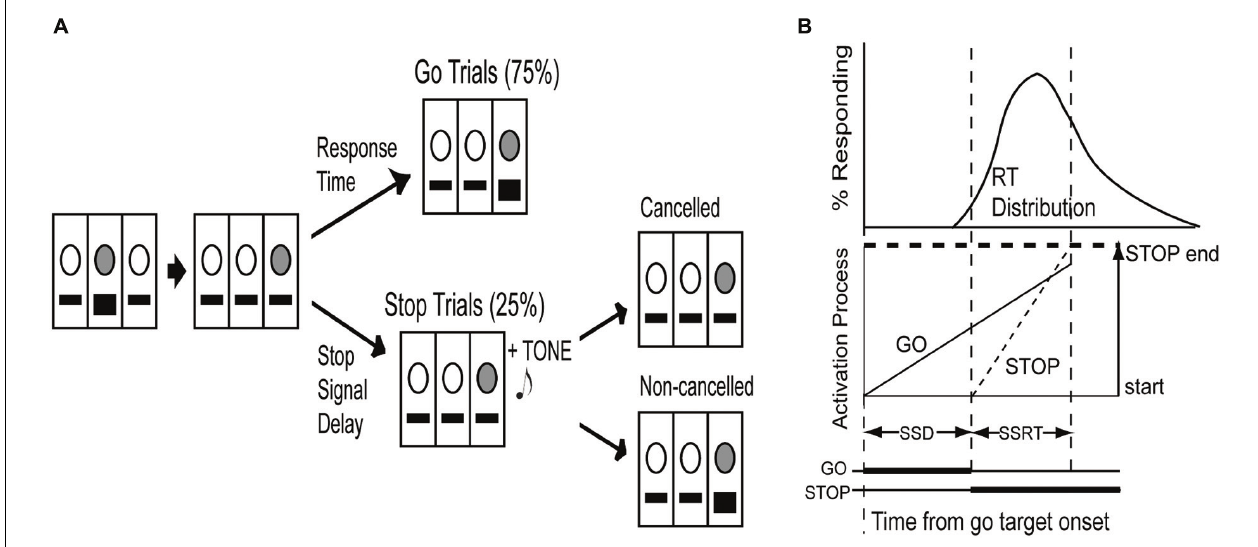
FIGURE 1 | The countermanding paradigm in rats. (A) The light above the center lever was illuminated (indicated by gray circle) and required a center lever press (indicated by black square) to initiate a trial. Upon center lever press, a light was immediately illuminated randomly above either the left or right lever, acting as the go stimulus. On go trials (75%), pressing the lever directly below the illuminated light before the end of a time limit resulted in food reward. On stop trials (25%) an auditory tone was presented as a stop signal at varying delays from go stimulus onset and required cancelation of the lever press for food reward, whereas a non-canceled lever press resulted in a 10-s timeout interval. (B) The race model of countermanding performance (Logan and Cowan, 1984) proposes that two independent processes, one initiated the go signal, the other by the stop signal, race toward a threshold, whereby the first process to cross the threshold wins the race and determines the behavioral outcome. The distribution of response times (RTs) can be integrated until the integral equals the probability of canceling a response at a given stop signal delay (SSD). The time at this point minus the stop process start time (i.e., stop signal onset) can be represented as the stop signal response time (SSRT; adapted from Paré and Hanes,